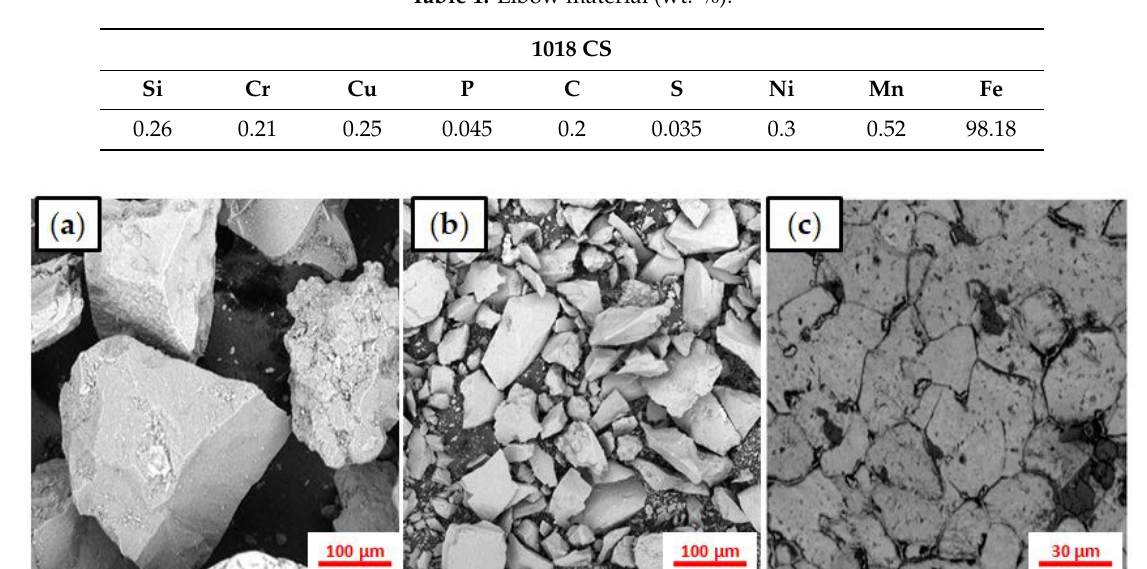
Figure 1. Ninety-Degree elbow specimen. ( a ) As received1018 CS ( b , c ) fine polished axially cut section. Table 1. Elbow material (wt. %).